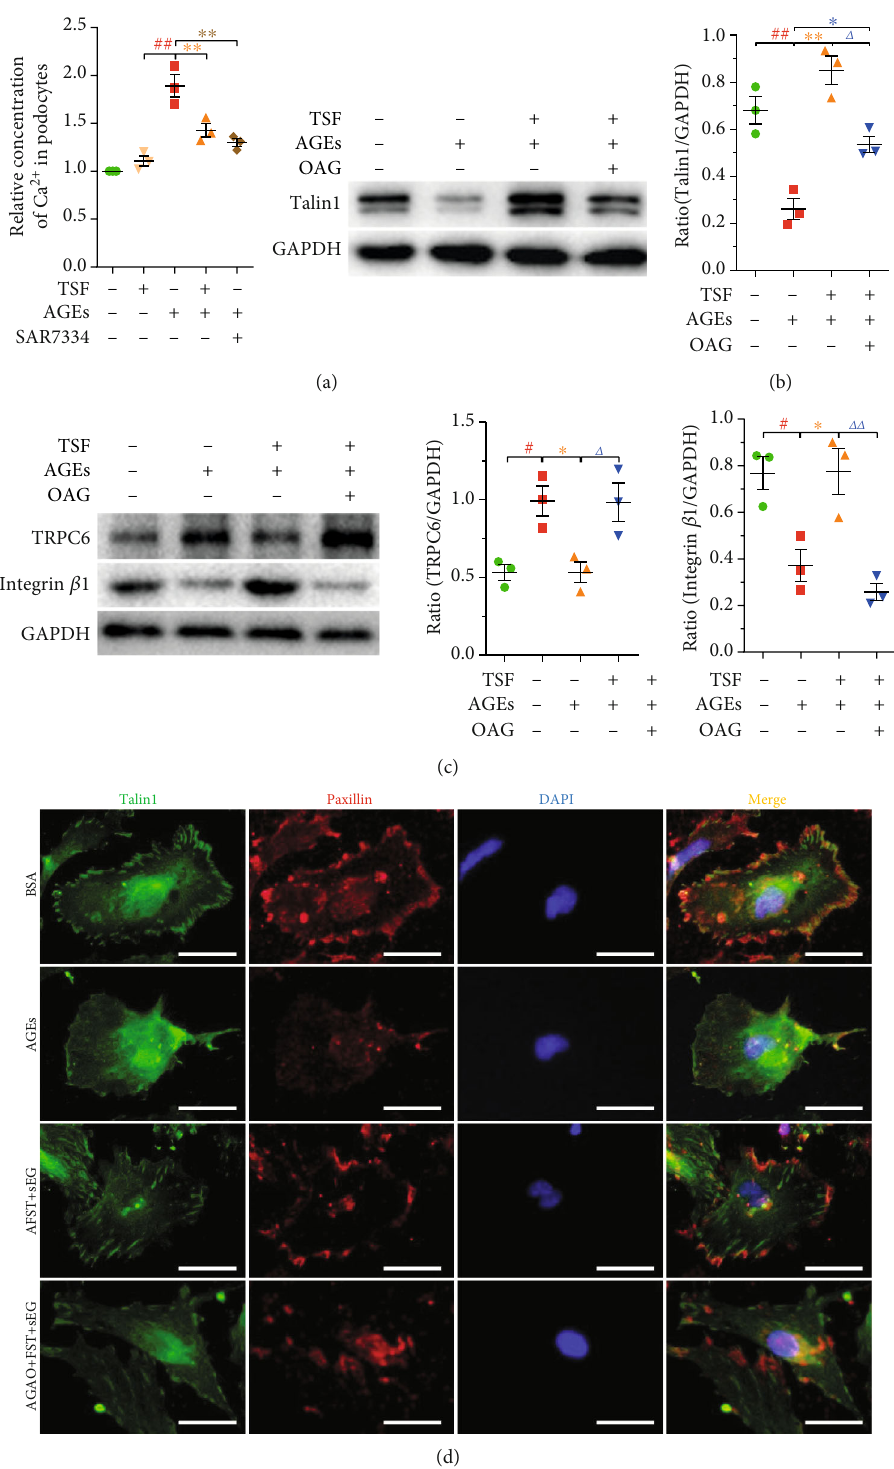
Figure 6: TSF improved TRPC6-dependent Ca 2+ accumulation-mediated reduction of focal adhesions in AGEs-stimulated primary mice podocytes. (a) E ff ects of TSF or SAR7334 on intracellular Ca 2+ level of AGEs-induced primary mice podocyte injury ( n = 3 experiments). (b) Immunoblotting and quantitative analysis of talin1 ( n = 3 experiments). (c) Immunoblotting and quantitative analysis of TRPC6 and integrin β 1 ( n = 3 experiments). (d) Representative immuno fl uorescence stained with talin1 (green) and paxillin (red) (scale bars, 50 μ m). The data were expressed as the mean ± SEM of three independent experiments performed in triplicate. # P < 0 : 05 , ## P < 0 : 01 vs. BSA group; ∗ P < 0 : 05 , ∗∗ P < 0 : 01 vs. AGEs group; Δ P < 0 : 05 , ΔΔ P < 0 : 01 vs. AGEs + TSF group. Statistically analyzed via a one-way